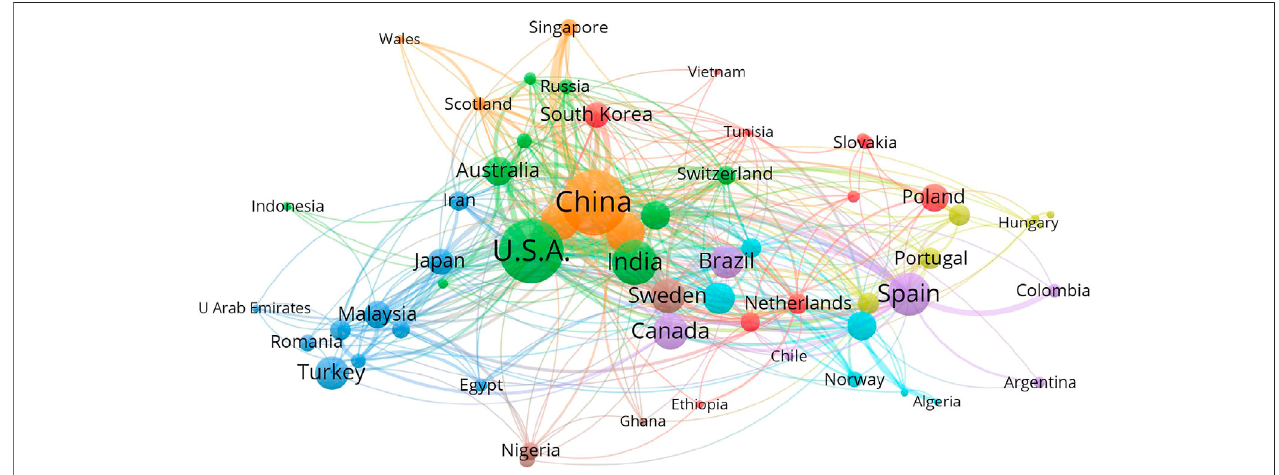
FIGURE 1 | Distribution of research activities on forest biomass to replace fossil-based energy carriers globally and the research interrelations between different countries.